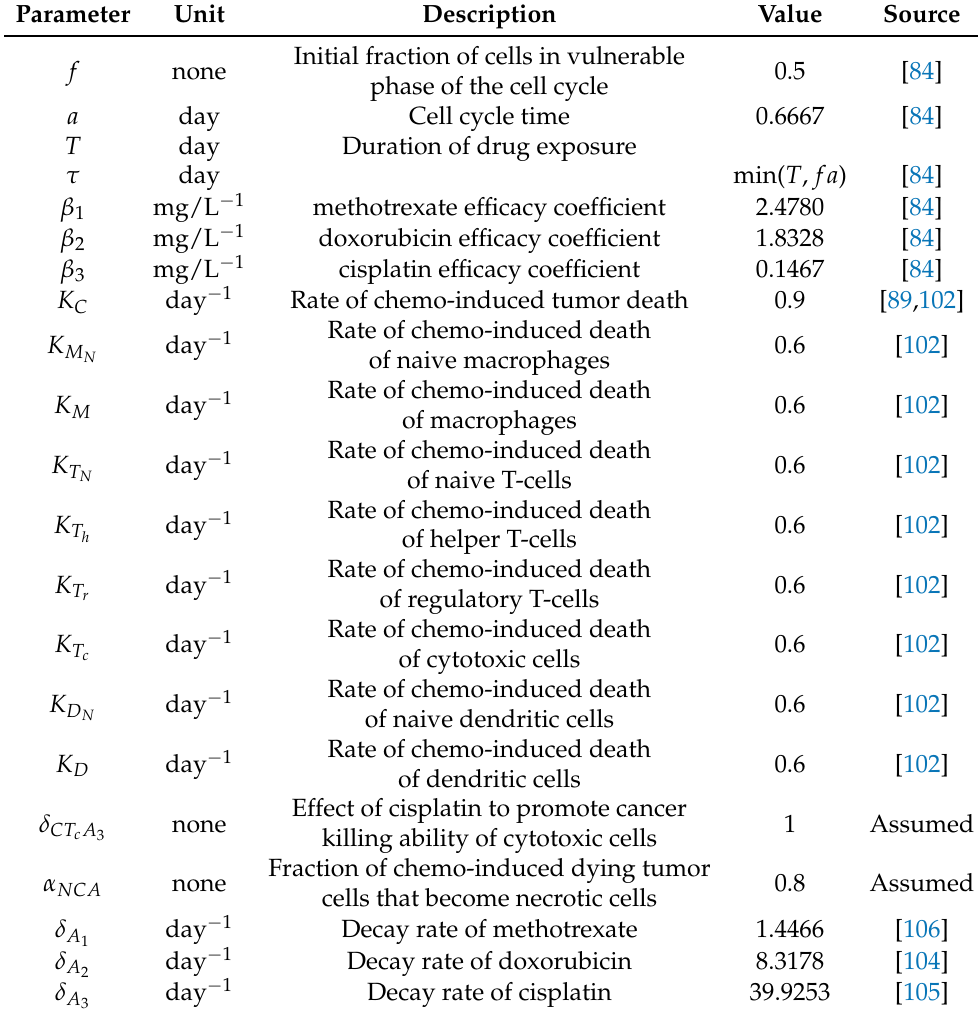
Table 2. Chemotherapy Parameters. Names, units, descriptions, values, and sources of chemotherapy- related parameters used in the